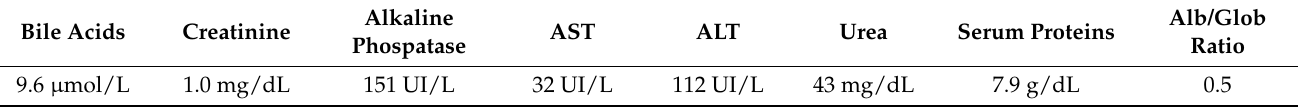
Table 2. Dog 2 biochemical parameters.